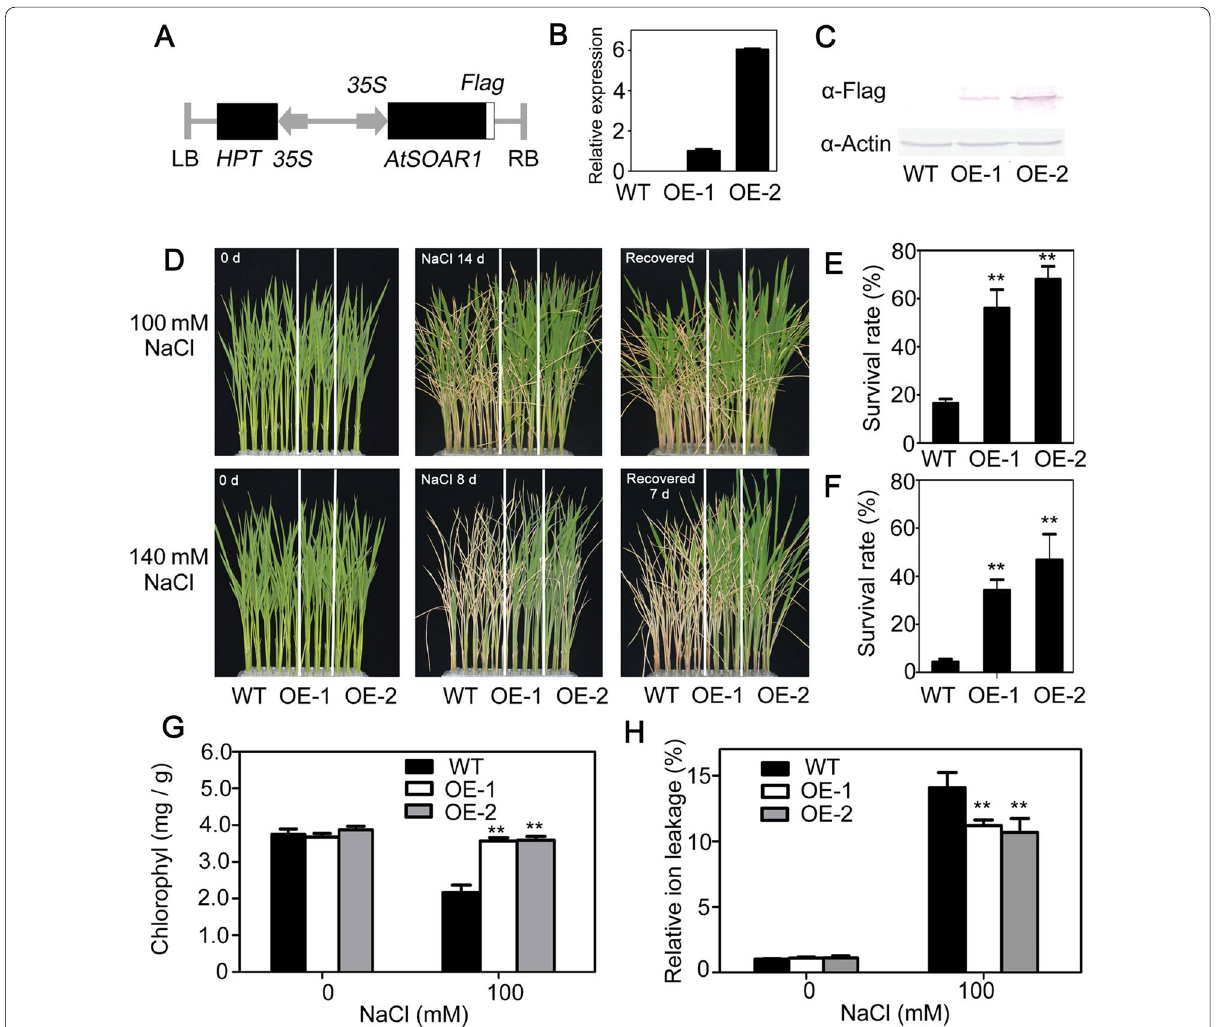
Fig. 1 Performance of AtSOAR1 ‑transgenic plants under salt stress in early seedling stage. A Schematic diagram of the AtSOAR1 ‑containing plant expression vector used for rice transformation. B Real‑time PCR detection of AtSOAR1 transcripts level in wild‑type and the two transgenic lines. Total RNA was extracted from two‑week‑old seedlings and used for cDNA synthesis. Actin1 was used for internal control and the expression level of AtSOAR1 in OE‑1 was taken as 1. All the values are means SE from three independent biological determinations. C Western bolt analysis of ± AtSOAR1 expression in wild‑type and two transgenic lines. Total protein was extracted from two‑week‑old seedlings and used for immunoblotting. Actin protein was taken as a loading control for immunoblotting. D Phenotypic comparison of wild‑type and AtSOAR1‑transgenic plants OE‑1 and OE‑2 grown under different concentration of NaCl solution (100 and 140 mM) at the seedling stage. Hydroponic cultured two‑week‑old seedlings were treated with 100 mM NaCl for 14d or 140 mM NaCl for 8d, and then recovered for 7 d. Three independent biological determinations were conducted and similar results were obtained. E , F Survival rates of the wild‑type and transgenic plants as described in (d) after 7d recovery. All the values are means SE from three independent biological determinations. Student’s t test was used for comparing the survival rate of each ± overexpression line with those of wild‑type plants (with significant differences at ** P < 0.01). G , H Chlorophyll content G and relative ion leakage H of the wild‑type and transgenic plants under normal and salt stress conditions. Two‑week‑old seedlings were treated with 100 mM NaCl for 9 d to assay chlorophyll content, or for 24 h to detect relative ion leakage. Student’s t test was used for comparing the chlorophyll content or relative ion leakage of each overexpression line with those of wild‑type plants (with significant differences at ** P <